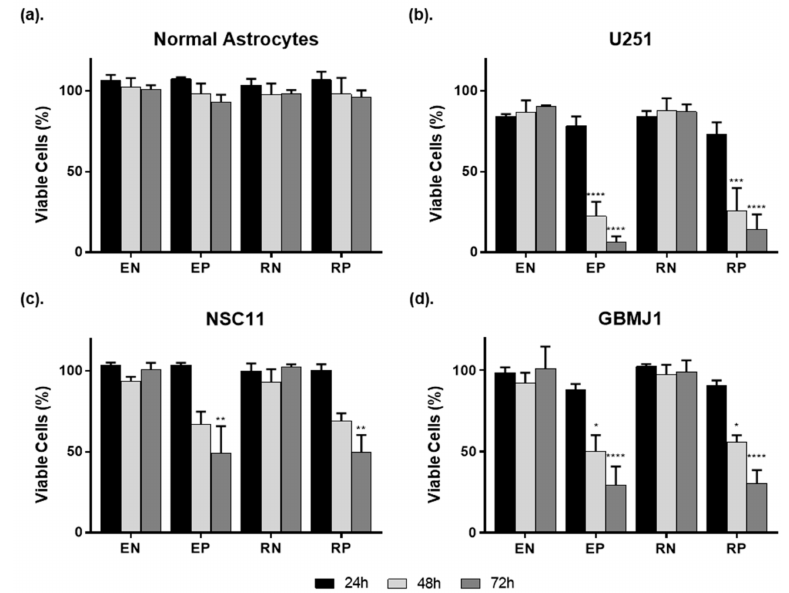
Figure 1. Cell viability over time during exposure to unlabeled and Arg-Gly-Asp and polyethylene glycol (RGD-PEG) labeled ECO nanoparticles (NPs). ( a ) Normal astrocytes, ( b ) U251 GBM cells, and GBM stem-like cell lines ( c ) NSC11 and ( d ) GBMJ1 were evaluated. Cells receiving no NP treatment were used as control for each day (100% viability). Values are shown as the mean ± SEM of 3 independent experiments. (Significance compared to negative siRNA controls and calculated by ANOVA with Tukey post-analysis: * p < 0.5, ** p < 0.01, *** p < 0.001**** p < 0.0001); (E—unlabeled